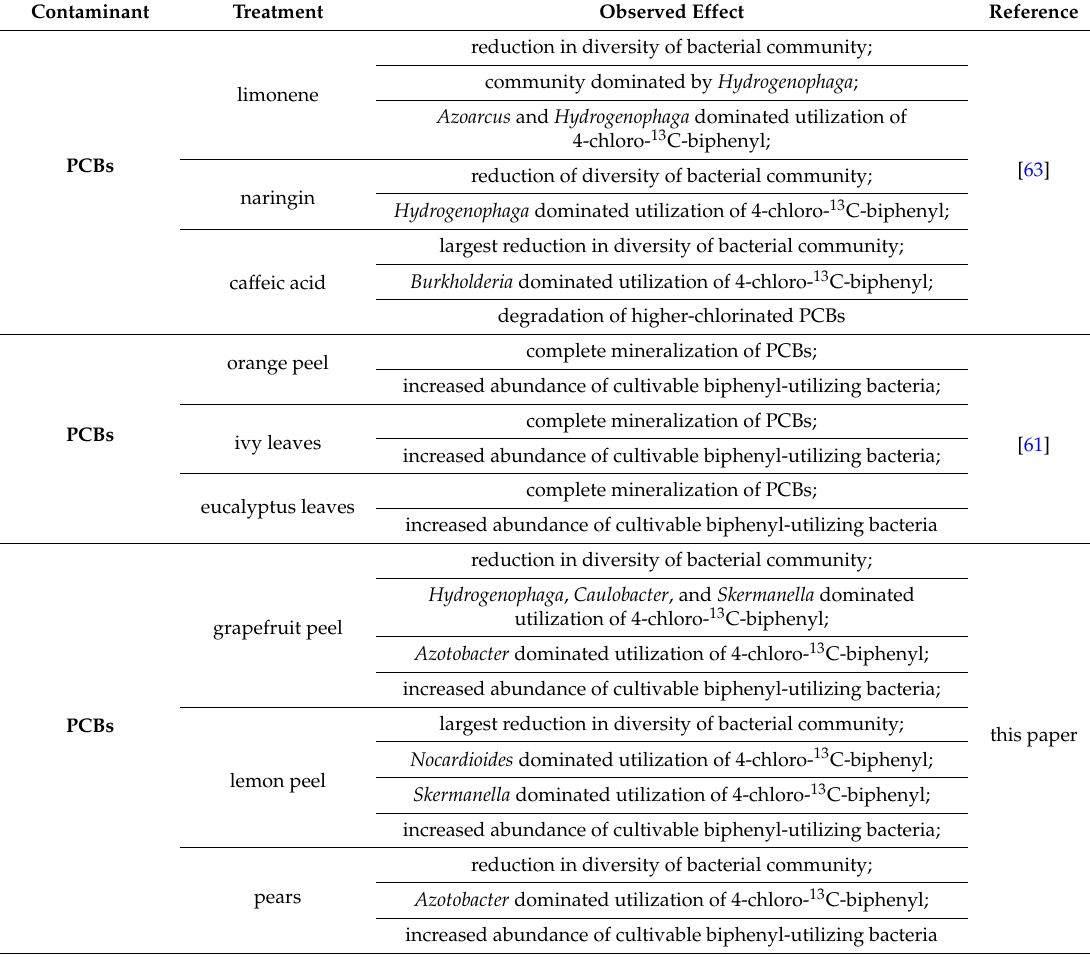
Table 2. Examples of treatments that led to changes in microbial community structure and activity towards